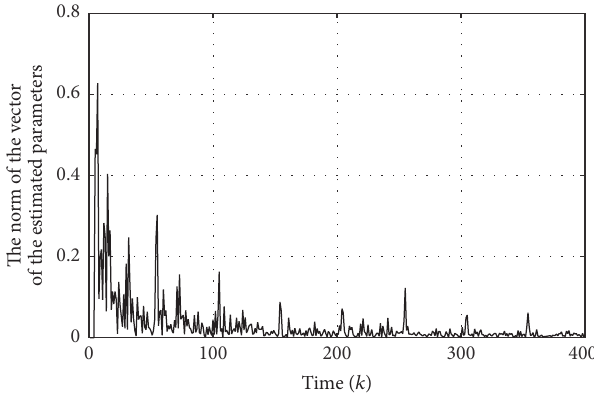
Figure 9: Evolution curve of the norm of the vector of the estimated ‖̂𝜃(𝑘)‖ parameters .